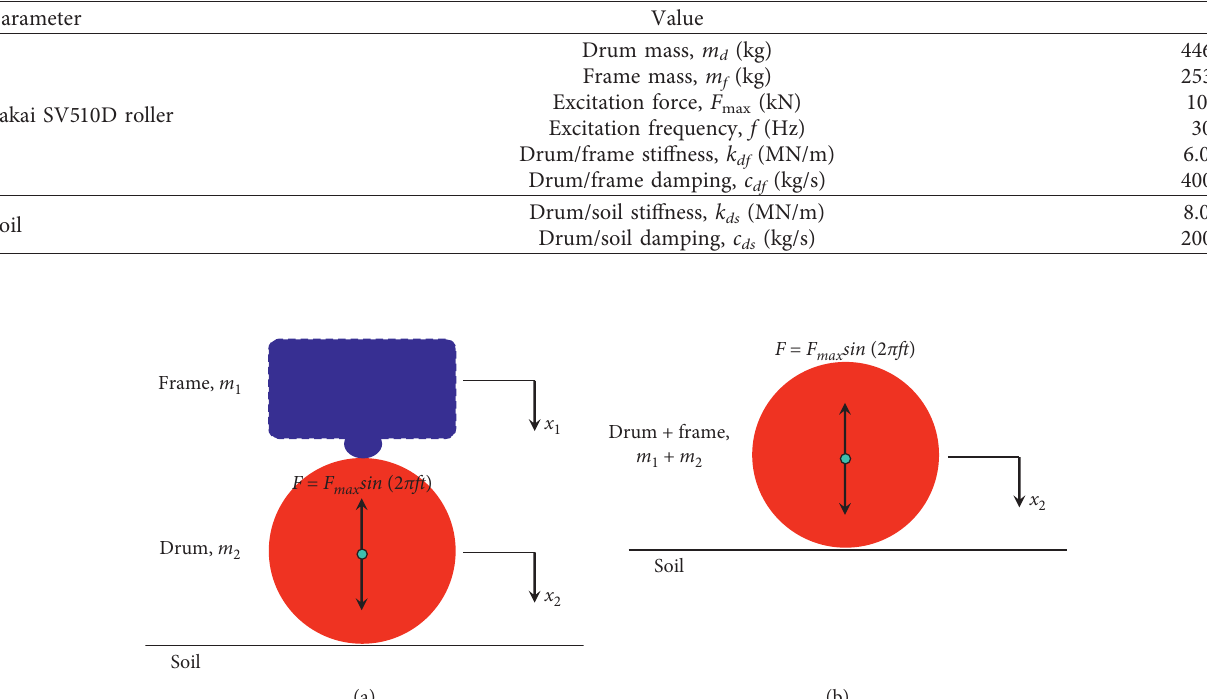
Figure 7: The developed numerical model of vibratory roller. Table 1: Sakai SV510D Roller and soil parameters.